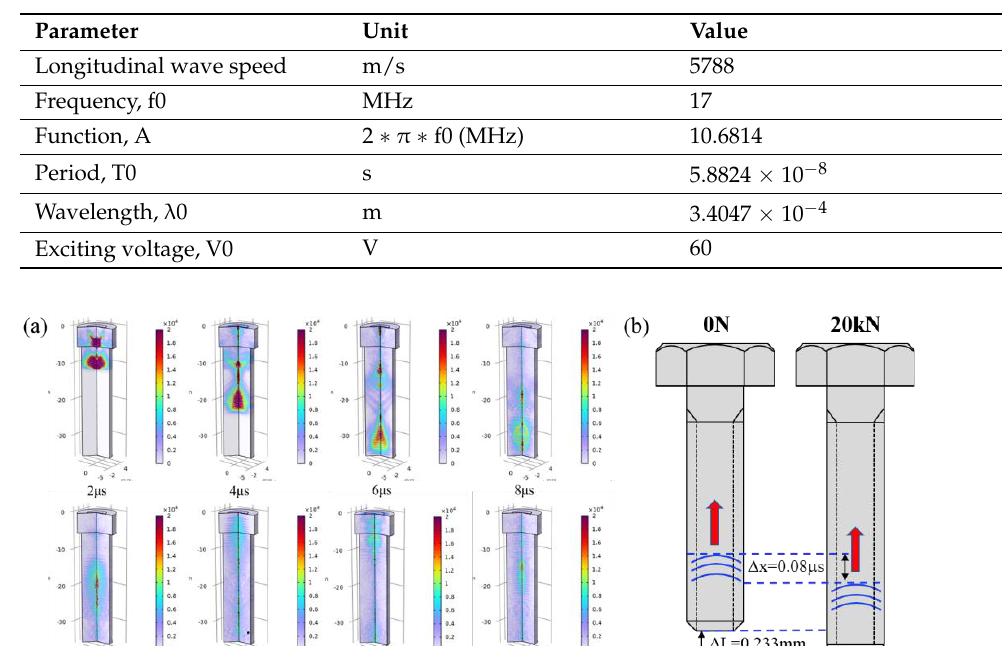
Figure 3. ( a ) Evolution of the ultrasonic wave inside the nickel − based superalloy bolt, ( b ) schematic diagram of ultrasonic wave propagation difference between the slack bolt and the bolt with 20 kN applied.